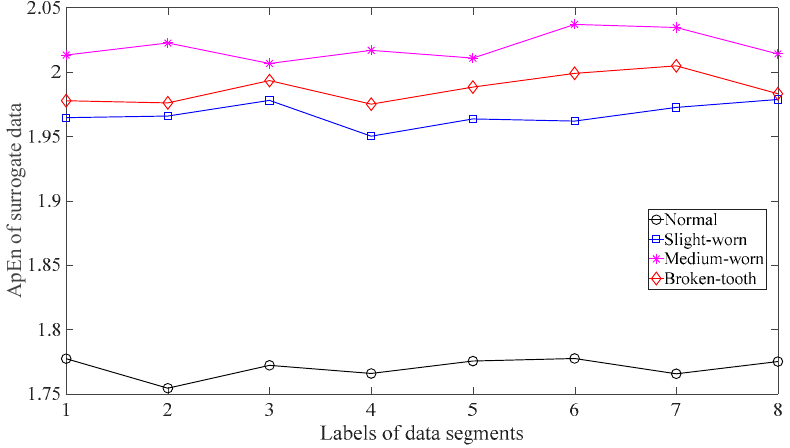
Figure 8. ApEn of the surrogate versions of the four types of gear vibration data.